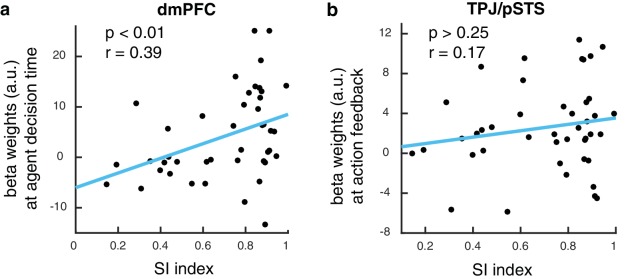
dmPFC signal predicts performance in slot machine game.(A) Scatter plot showing beta estimates of outcome prediction signals in the dmPFC ROI across participants, plotted against the social information integration index (SI index), which characterizes each participant’s performance in the slot machine game. The higher the score, the better the participants are at inferring the best option for themselves from observing the other. (B) Scatter plot of entropy update signals in the TPJ/pSTS ROI across participants plotted against the social information integration index.